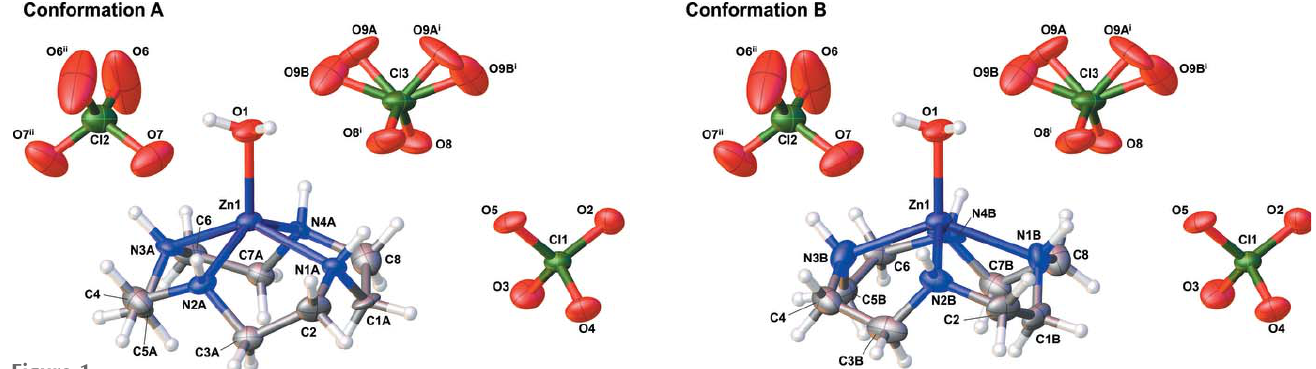
Figure 1 The structures of the molecular entities within the title complex showing 50% displacement ellipsoids. [Symmetry codes: (i) (cid:2) x + 1, y , (cid:2) z + 1 (cid:2) z + 1 2